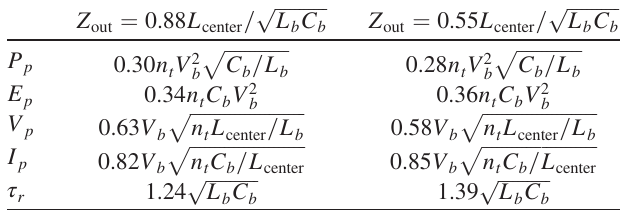
ffiffiffiffiffiffiffiffiffiffiffiffiffiffiffiffiffiffiffiffiffiffiffiffi p ffiffiffiffiffiffiffiffiffiffiffiffiffiffiffiffiffiffiffiffiffiffiffiffi L =L n t b ffiffiffiffiffiffiffiffiffiffiffiffiffiffiffiffiffiffiffiffiffiffiffiffi p ffiffiffiffiffiffiffiffiffiffiffiffiffiffiffiffiffiffiffiffiffiffiffiffi center C =L n t b center